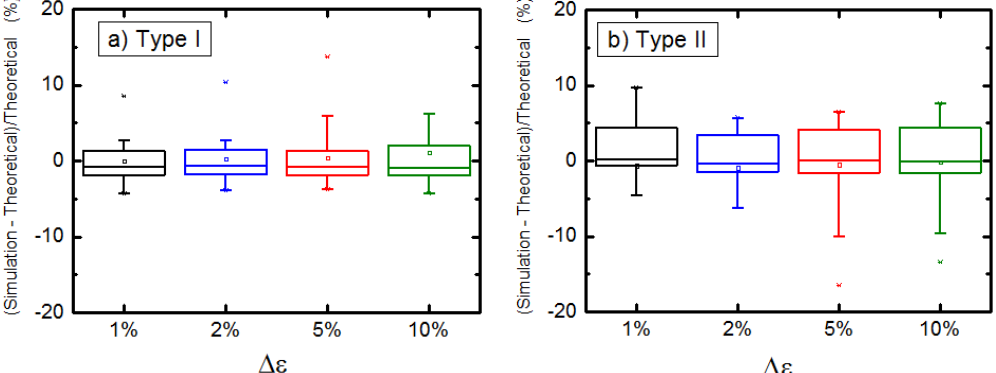
Fig. 4. For the effective radius, box-and-whisker diagrams of the differences between the theoretical deviations computed with the slopes of Table 1 and the simulated deviations. At least two optical channels have been simultaneously perturbed by biases of the same magnitude although different combinations of over/underestimations are allowed. In these box diagrams the mean is represented by an open square. The line segment in the box is the median. The top limit represents the 75th percentile (P75) and the bottom limit the 25th percentile (P25). The box bars are related to the 1st (P1) and 99th (P99) percentiles, and the crosses represent the maximum and minimum values, respectively. We used biases in the optical data of 1% (black diagrams), 2% (blue diagrams), 5% (red diagrams) and 10% (green diagrams).